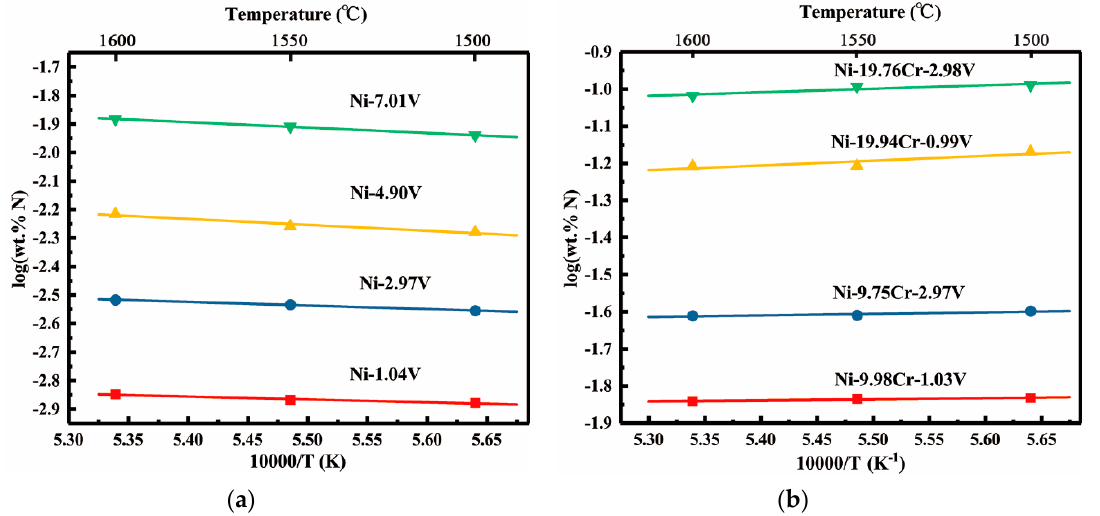
Figure 5. ( a ) Experimental results of the temperature dependence of the nitrogen solubility in the liquid Ni-V alloys; ( b ) Experimental results of the temperature dependence of the nitrogen solubility in the Ni-Cr-V alloys.